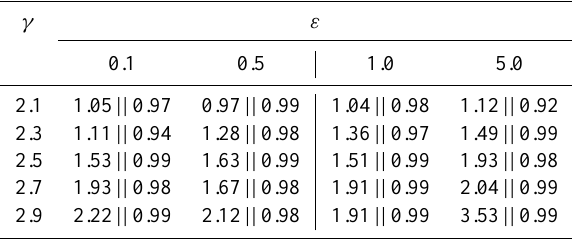
Table 1. The values δ in the distribution of polarity intervals ν ∼ 1 /ζ δ and correlation coefficients ρ between log ν and log ( 1 /ζ) . In the format δ || ρ